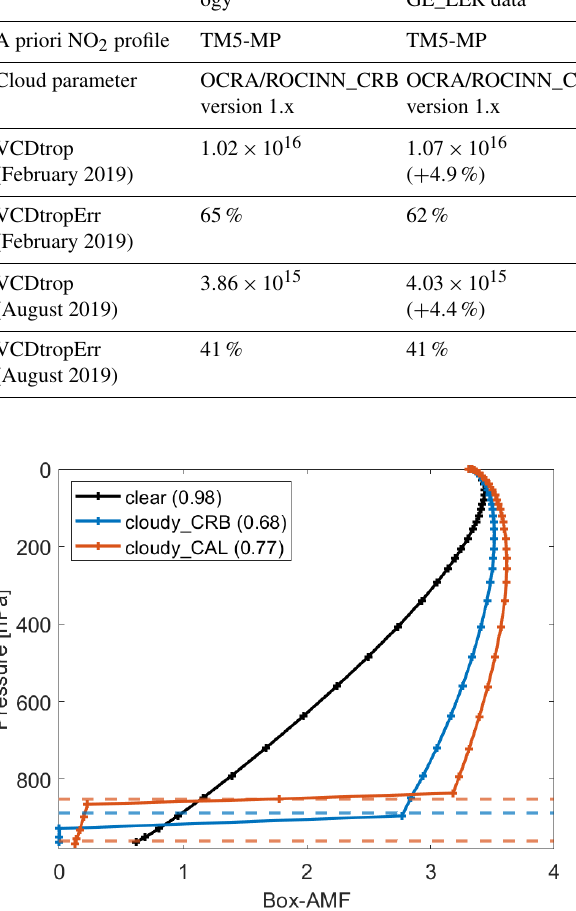
Figure 16. Box-AMFs for clear and cloudy sky using the ROCINN_CRB and ROCINN_CAL cloud models over Munich in Germany (48.15 ◦ N, 11.57 ◦ E) on 5 February 2019. The calculated tropospheric AMF is given in brackets next to each label in the leg- end. The ROCINN_CRB cloud top pressure is shown as a horizontal dotted blue line, and the ROCINN_CAL cloud top and base pres- sures are shown as horizontal dotted brown